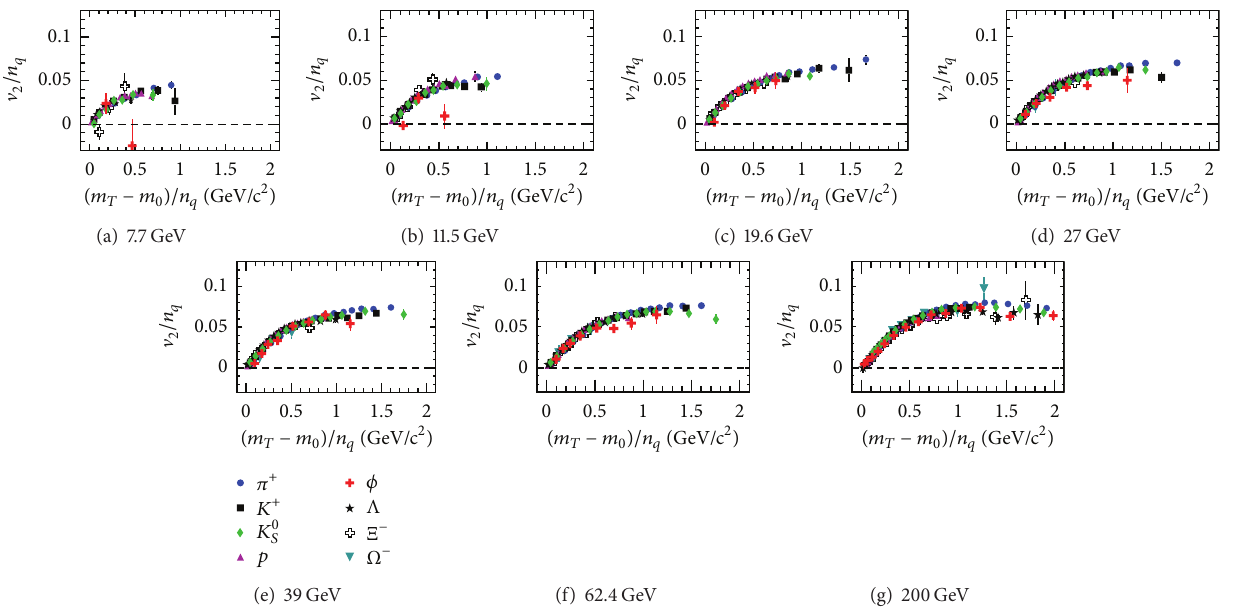
Figure 11: The NCQ-scaled elliptic flow, V 2 /𝑛 𝑞 , versus (𝑚 𝑇 − 𝑚 0 )/𝑛 𝑞 for 0–80% central Au + Au collisions for selected identified particles [28–30]. Only statistical error bars are